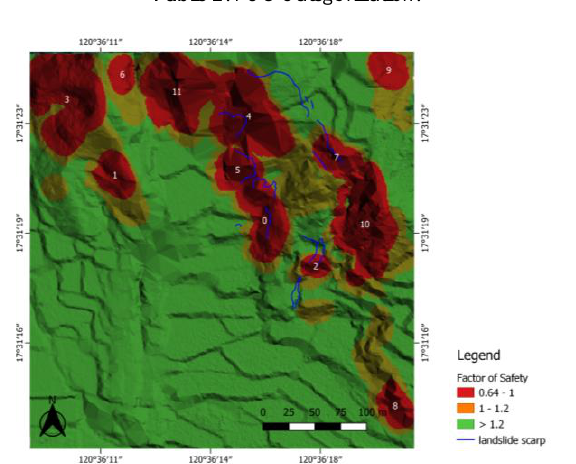
Figure 10 . Landslide Failure Surfaces.